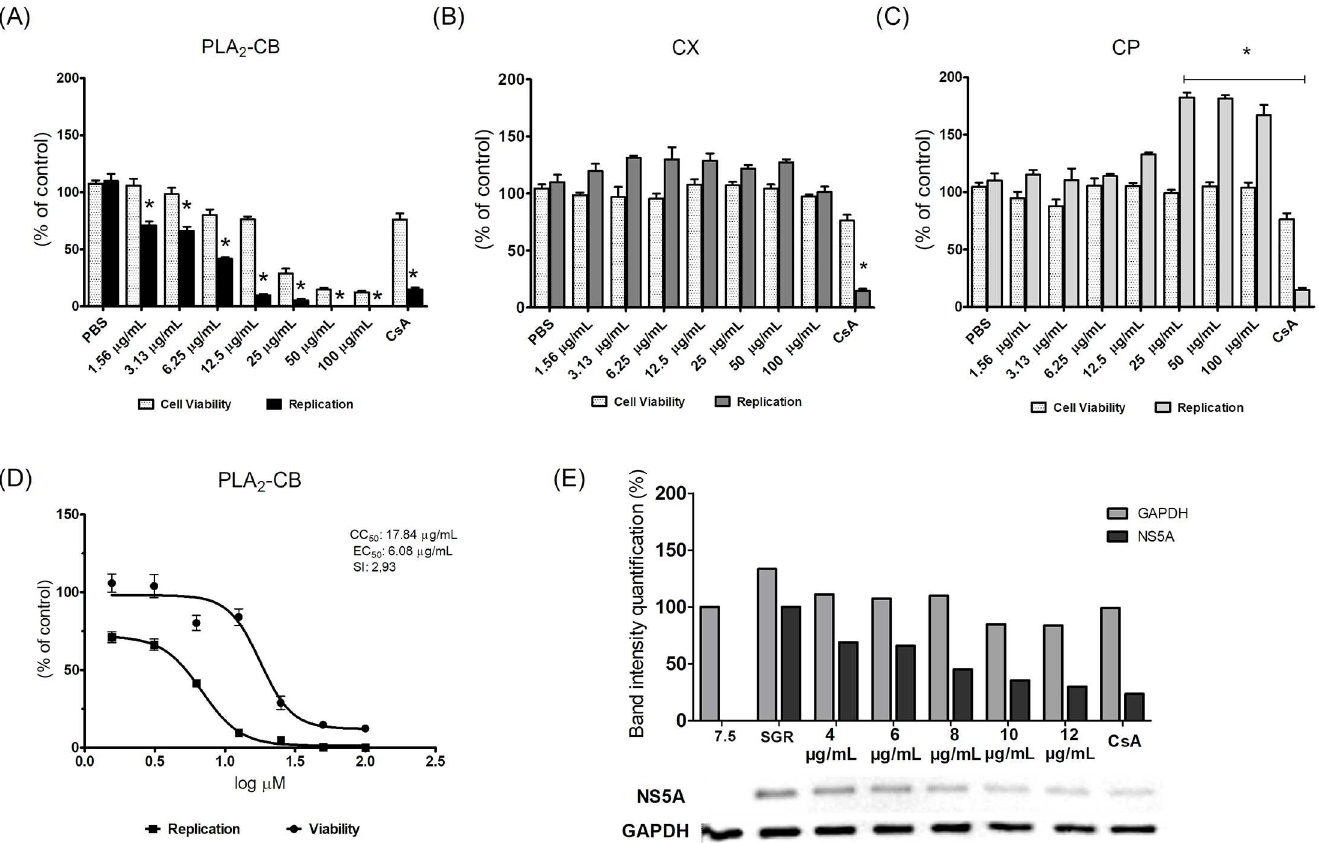
Fig 2. Inhibitory activity of the toxins on HCV replication. Huh-7.5cell line stably expressingSGR-luc-JFH-1 were treated with PLA 2 -CB (A), CX (B), CP (C) at specific concentrations for 48 h. The effective concentration of inhibition(EC 50 ), the cytotoxic concentration of 50% (CC 50 ), and the selectivity index (SI = CC 50 /EC 50 ) were calculated(D). Expression of HCV NS5A protein was measured 48 h post-treatment using western blotting assays (E). Mean values of three independent experiments each measured in triplicate includingthe standarddeviationare shown. P < 0.001 was considered significant( * ).